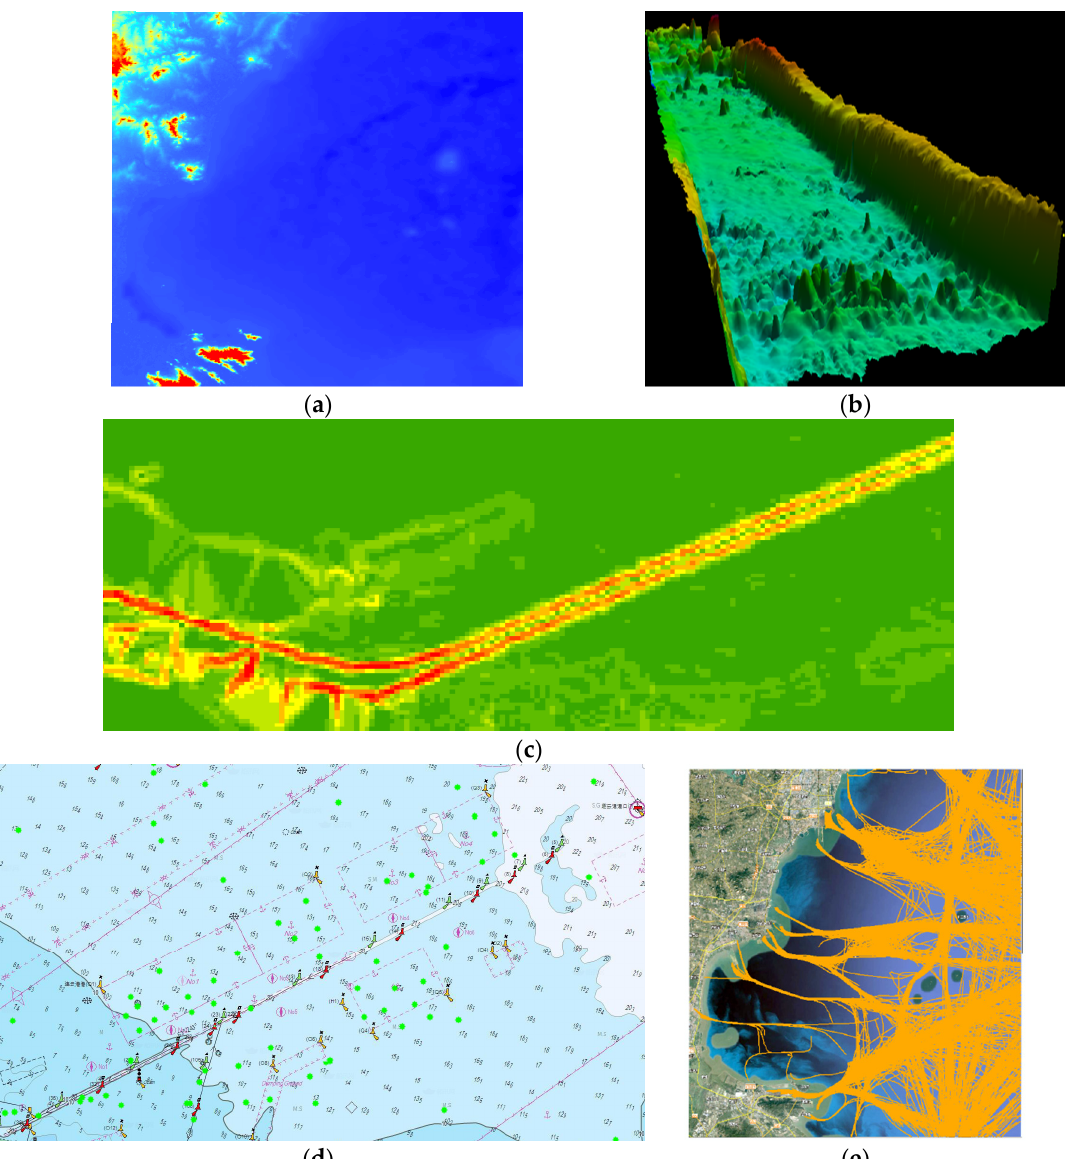
Figure 1. Data elements used in this study. ( a ) Gebco global water depth data; ( b ) bathymetric data; ( c ) topographic slope analysis; ( d ) electronic chart; ( e ) data of ship traffic flow.